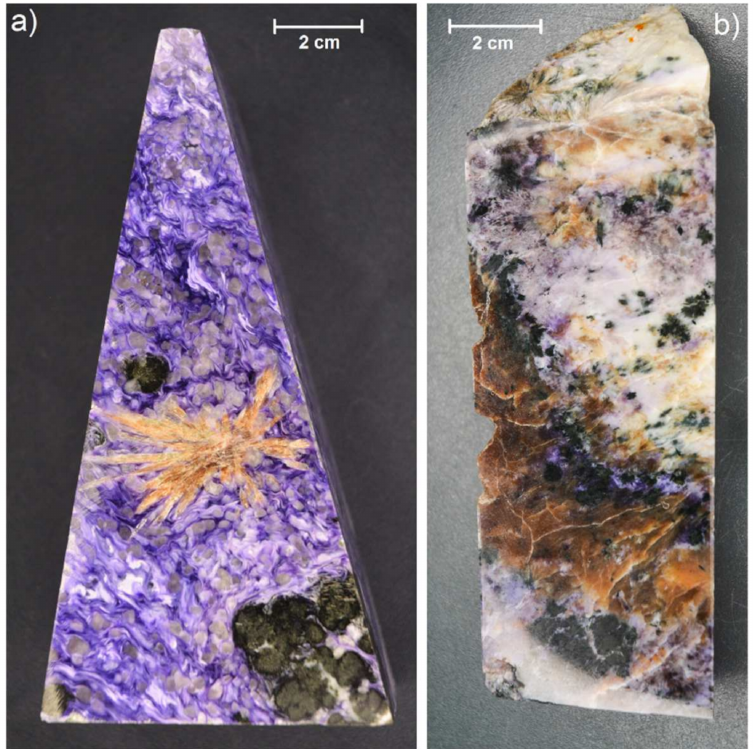
Figure 2. The polished side of the sample of tinaksite-containing ( a ) and tokkoite-containing ( b ) charoitite. Tinaksite ( a ) is light brown, tokkoite ( b ) is light brown to brown, charoite is violet. The specimens are deposited at the Sidorov State Mineralogical Museum (INRTU, Irkutsk, Russia). Photo by Tatiana